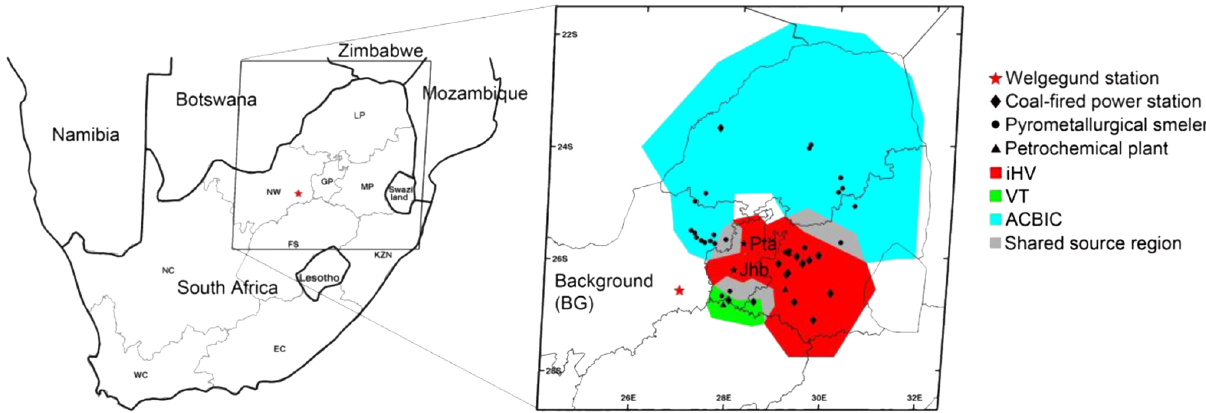
Fig. 1. Location of the Welgegund measuring site (marked as red star) and major source regions marked with colours. The grey areas on this map indicate where there is a likelihood that the various source regions overlap. Trajectories passing over these regions of uncertainty were rejected (see Beukes et al. (2014) for